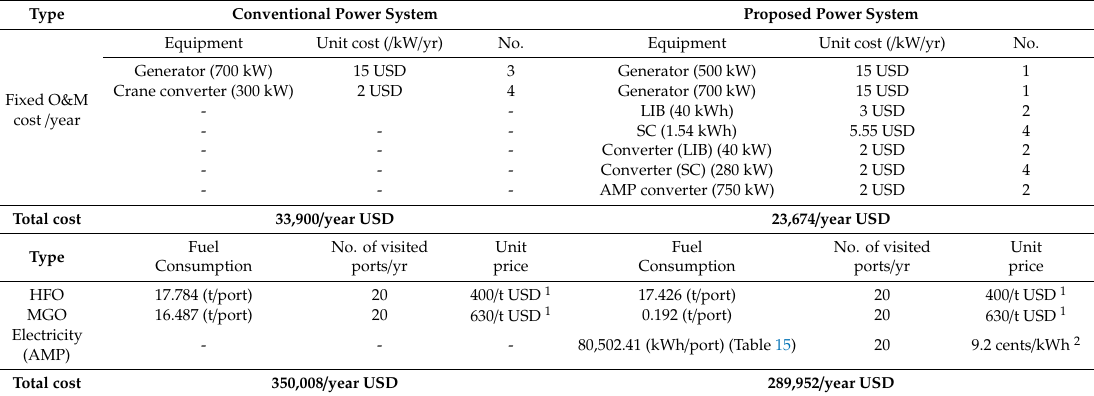
Figure 12. Cumulative saving costs for the lifespan of a ship depending on each variation. Table 19. Comparison of the operational expenditure (OPEX) for each system per year.